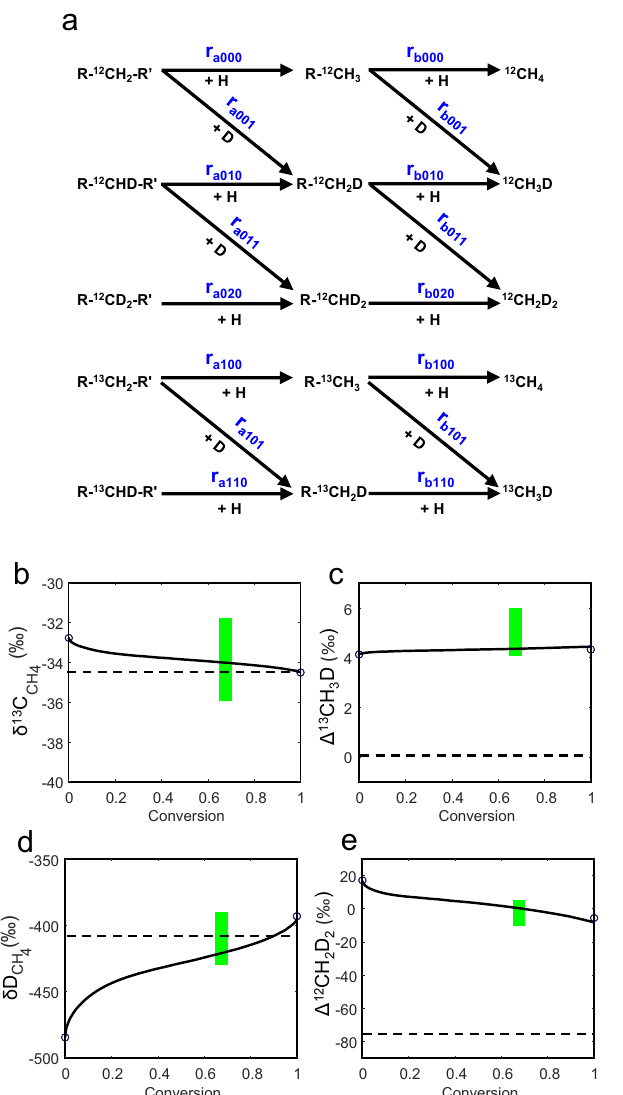
Fig. 3 Numerical simulation on the isotopic compositions of CH 4 from hydrogen biodegradation of long alkyl chains. a Reaction scheme showing isotope distribution during the hydrogenolysis of long C – C chains. b – e variations of δ 13 C, Δ 13 CH 3 D, δ D, and Δ 12 CH 2 D 2 with conversion (fraction of CH 4 -contained 12 C atoms in all 12 C atoms). Legend in b – e : dashed lines — kinetic isotope effects (KIEs) are absent and no enrichment/depletion of clumped isotopes in the organic precursor; solid lines — inverse deuterium KIE (DKIE) of the hydrogen donor (primary DKIE) present; circles — analytical solutions (Eqs. 12 and 13) at the start and end of conversion; green bars — range of reported data (conversion is set between 0.65 and 0.70 as constrained in Fig. 2). Parameters are listed in Table 1.